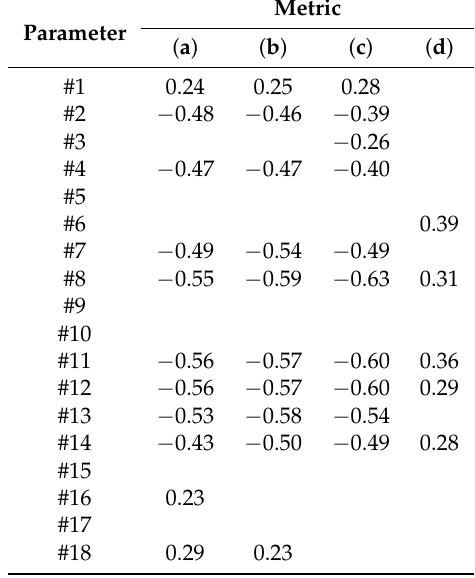
Table 3. Cross-covariance between characterization metrics and coherence